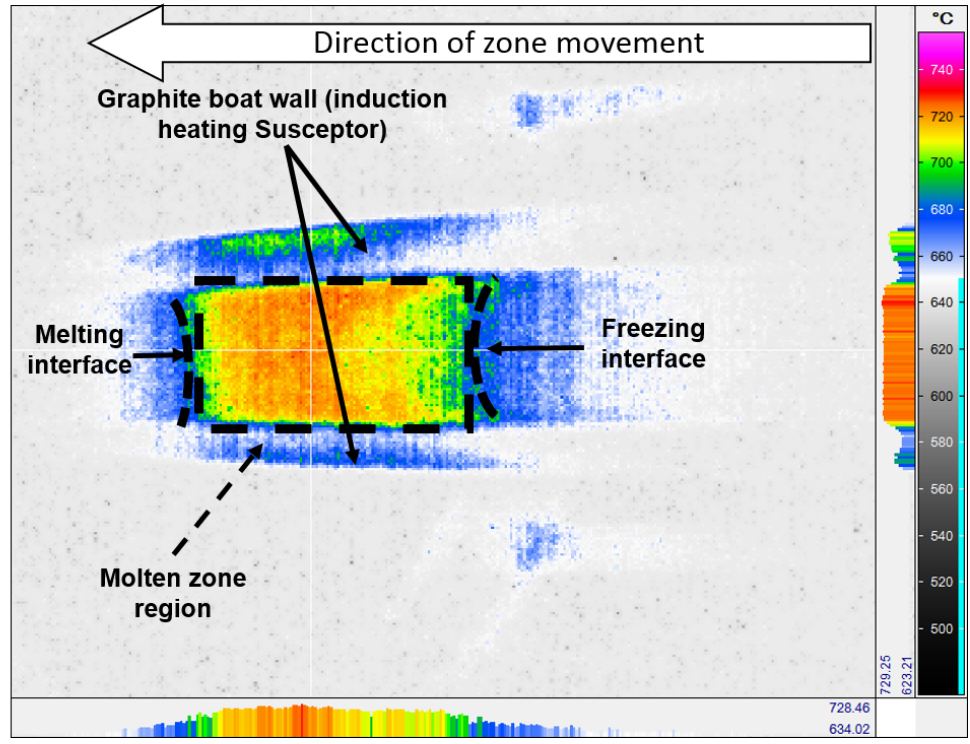
Figure 8. An infrared thermographic picture showing the zone length in the middle portion of the bar and the horizontal and vertical temperature profile at the middle of the molten